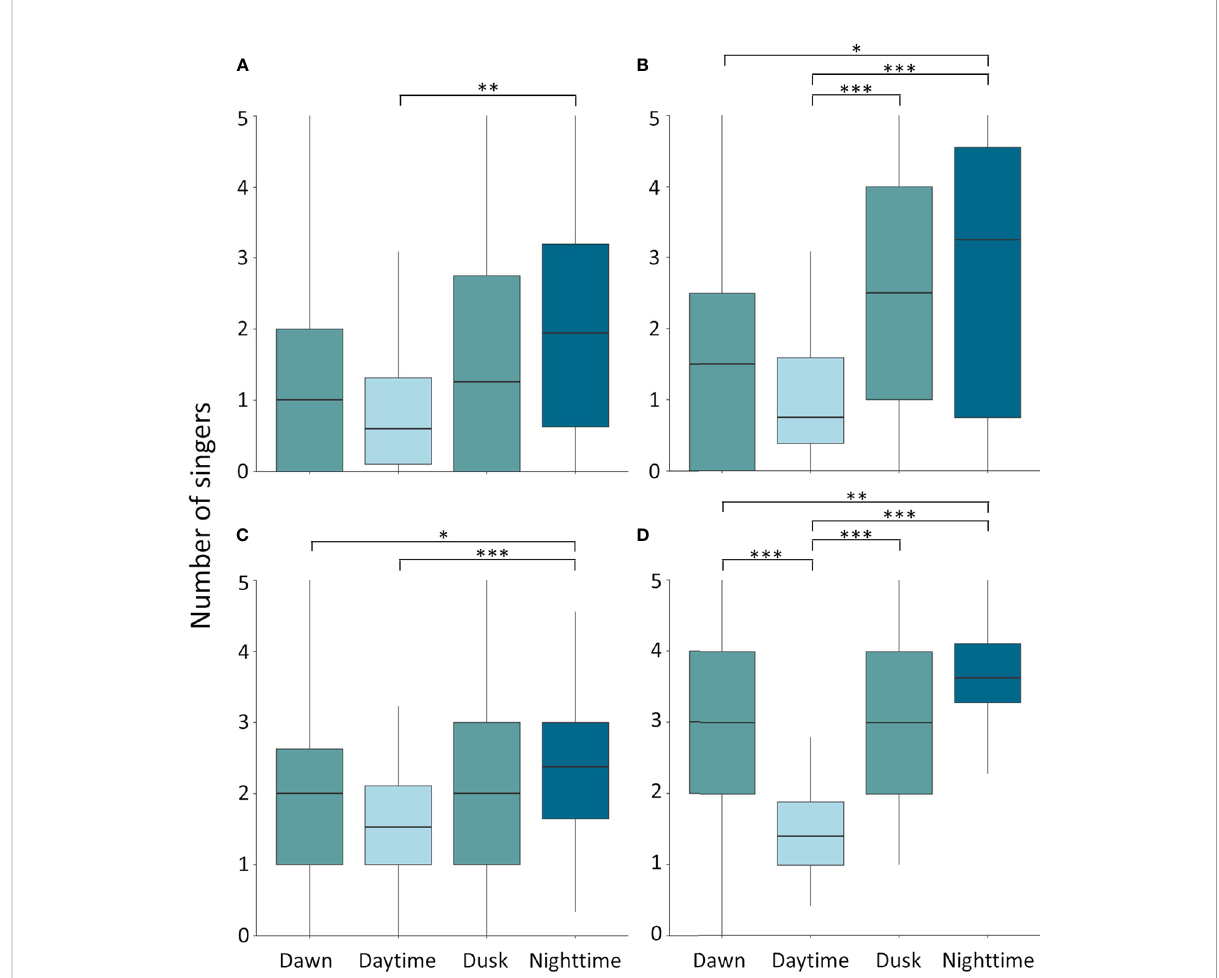
FIGURE 5 Diel patterns of humpback whale singing activity at Sally Tucker in spring 2018 (A) and Challenger Bank in spring 2018 (B) , winter 2018/19 (C) and spring 2019 (D) . The median number of singers (horizontal black line) varied signi fi cantly between daytime and nighttime in all four datasets. Boxes indicate the interquartile range and the vertical lines indicate the range of daily averages in the number of singers. Signi fi cance levels are illustrated with stars (*p < 0.05; **p < 0.01; ***p <